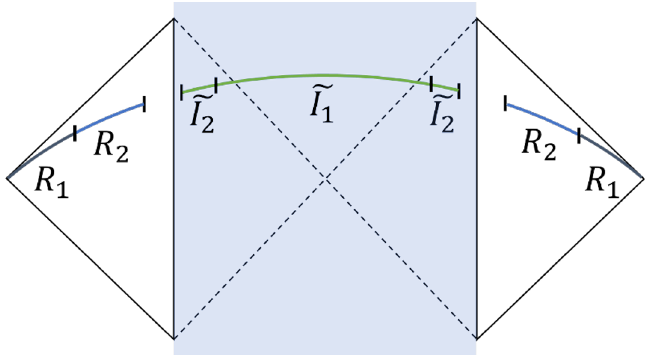
Figure 21 . Two subsystems R 1 and R 2 in the radiation. The island I of R = R 1 ∪ R 2 is divided into two parts ˜ I 1 and ˜ I 2 .